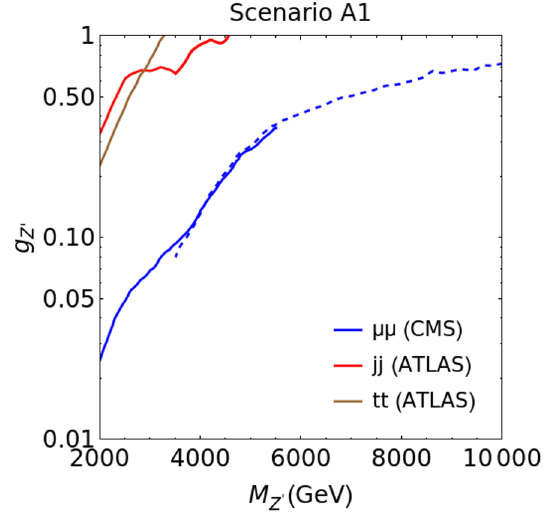
Figure 2 . Comparison of sensitivities of t ¯ t [63], dijet [65] and dimuon [33] resonance searches for the scenario A1 (which is likely to lead to the strongest t ¯ t bounds). The limits from dimuon channel are much stronger than the other searches. The dimuon limits are extrapolated in the range 5.5 GeV < M 0 ≤ 10 TeV (dashed) using the shape of the dimuon invariant mass spectrum, and can be seen Z to match those from the available dimuon CMS search [33] in the interval 3.5 GeV ≤ M 0